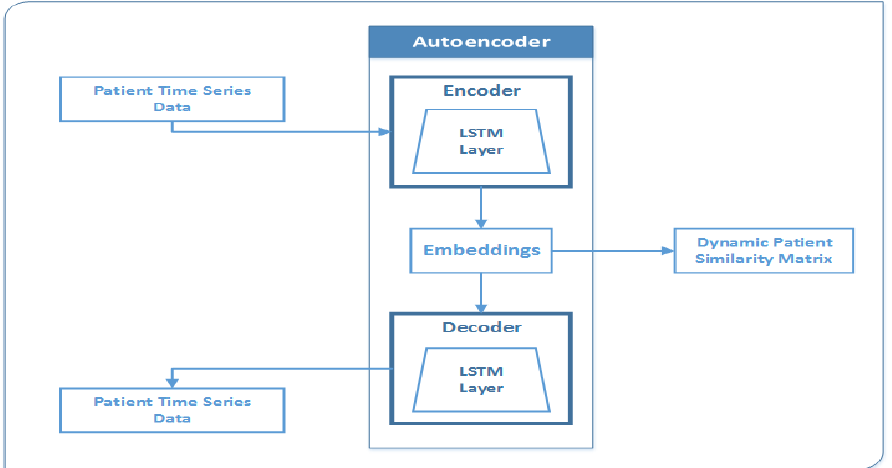
Figure 10. The architecture of the data reduction autoencoder.